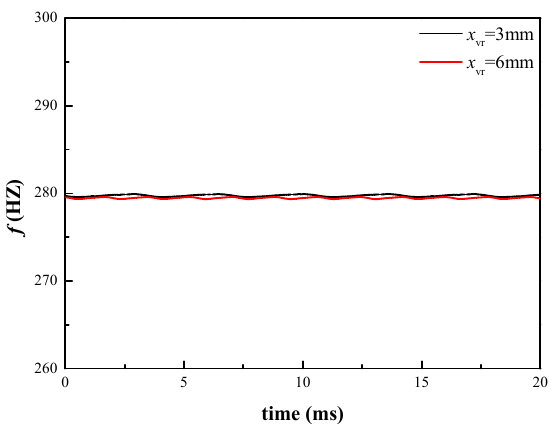
Figure 28. Reversing frequencies of different orifice axial lengths.